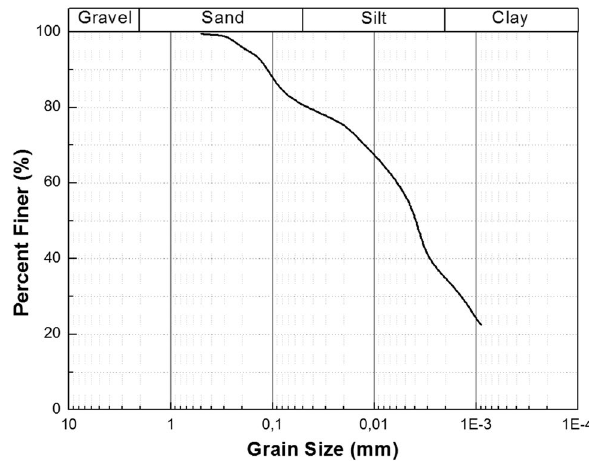
Fig. 3 Particle size distributions for Chorfa dam mud